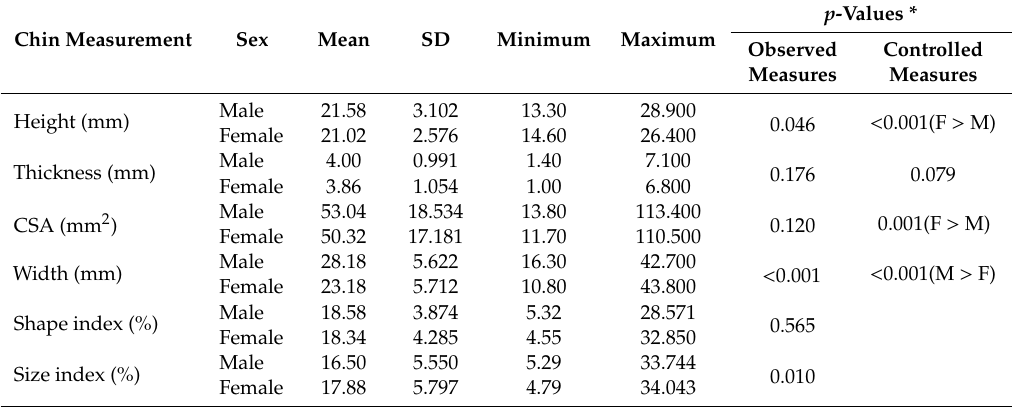
Table 4. Morphometric characteristics of the male and female chin (males n = 203, females n = 216).